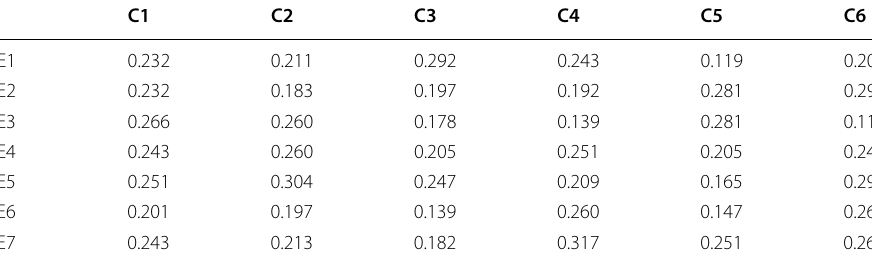
Table 20 Score function values of the economies